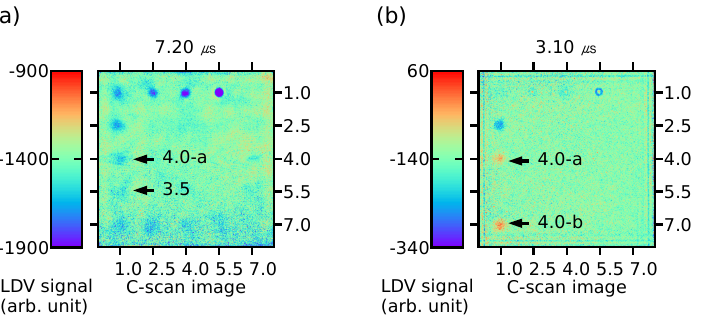
Figure 8. C-scan images of stainless steel STS304 and aluminum alloy AL6061 plates: ( a ) Stainless steel STS304 plate at 7.20 µ s in Band1 and ( b ) aluminum alloy AL6061 plate at 3.10 µ s in